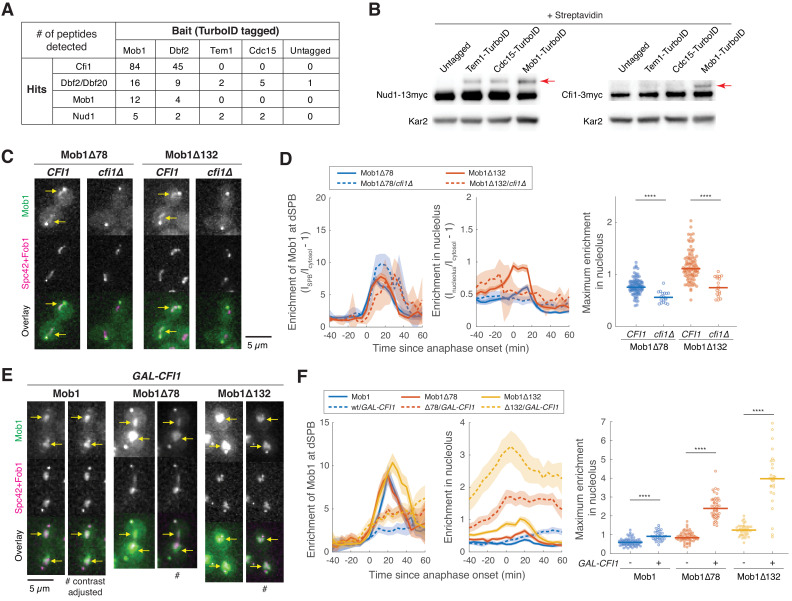
Dbf2-Mob1 localizes to the nucleolus through interacting with Cfi1/Net1.(A) Results of proximity-based biotinylation with TurboID for mitotic exit network (MEN) proteins (A41367, A41370, A41368, A41369, and A2588). Cells were grown at room temperature in YEP + 2% glucose + 50 μM biotin. (B) Streptavidin gel-shift assays to probe the interactions of TurboID-labeled MEN proteins with the MEN scaffold Nud1 (left, A11869, A41381, A41382 and A41380) or Cfi1/Net1 (right, A1638, A41406, A41407 and A41372). Cells were grown at room temperature in YEP + 2% glucose and lysates were treated with streptavidin and immunoblotted as indicated. Red arrows highlight biotinylated proteins. (C and D) Representative images (C) and quantification (D) of Mob1Δ78 localization in wild-type CFI1/NET1 (A41344, n = 106 cells) or cfi1/net1Δ (A41347, n = 18 cells) cells and Mob1Δ132 localization in CFI1/NET1 (A41345, n = 95 cells) or cfi1/net1Δ (A41348, n = 18 cells) cells. Cells were grown at 25°C in SC medium + 2% glucose and imaged every 5 min for 4 hr. Arrows highlight nucleolar localization. (E and F) Representative images (E) and quantification (F) of Mob1 localization in wild-type (A41343, n = 110 cells) or GAL-CFI1/NET1 expressing cells (A41340, n = 71 cells), Mob1Δ78 localization in wild-type (A41344, n = 103 cells) or GAL-CFI1/NET1 expressing cells (A41341, n = 68 cells), and Mob1Δ132 localization in wild-type (A41345, n = 71 cells) or cells expressing GAL-CFI1/NET1 (A41342, n = 53 cells). # denotes that the image was linearly contrast adjusted to avoid over-saturation for Mob1Δ78 and Mob1Δ132. Cells were first grown at room temperature in SC medium + 2% raffinose. Cells were then mounted onto agarose pads made with SC medium + 1% raffinose + 1% galactose and imaged every 5 min for 5 hr at 25°C. Arrows highlight nucleolar localization. Solid lines represent the average of single cell traces aligned to anaphase onset while shaded areas represent 95% confidence intervals. For maximum enrichment, each dot represents a single cell. The solid lines represent the median. ****p<0.0001 by two-sided Wilcoxon rank sum test.